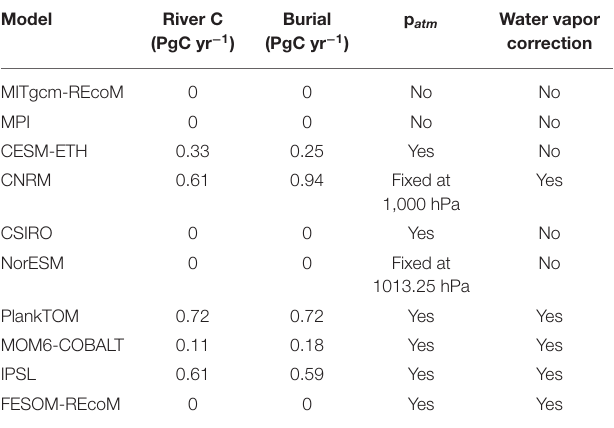
TABLE 1 | Specifications of Global Ocean Biogeochemical Models: River carbon input, net burial and conversion from xCO 2 (ppm) to p CO 2 ( µ atm) using atmospheric sea-level pressure p atm and water vapor